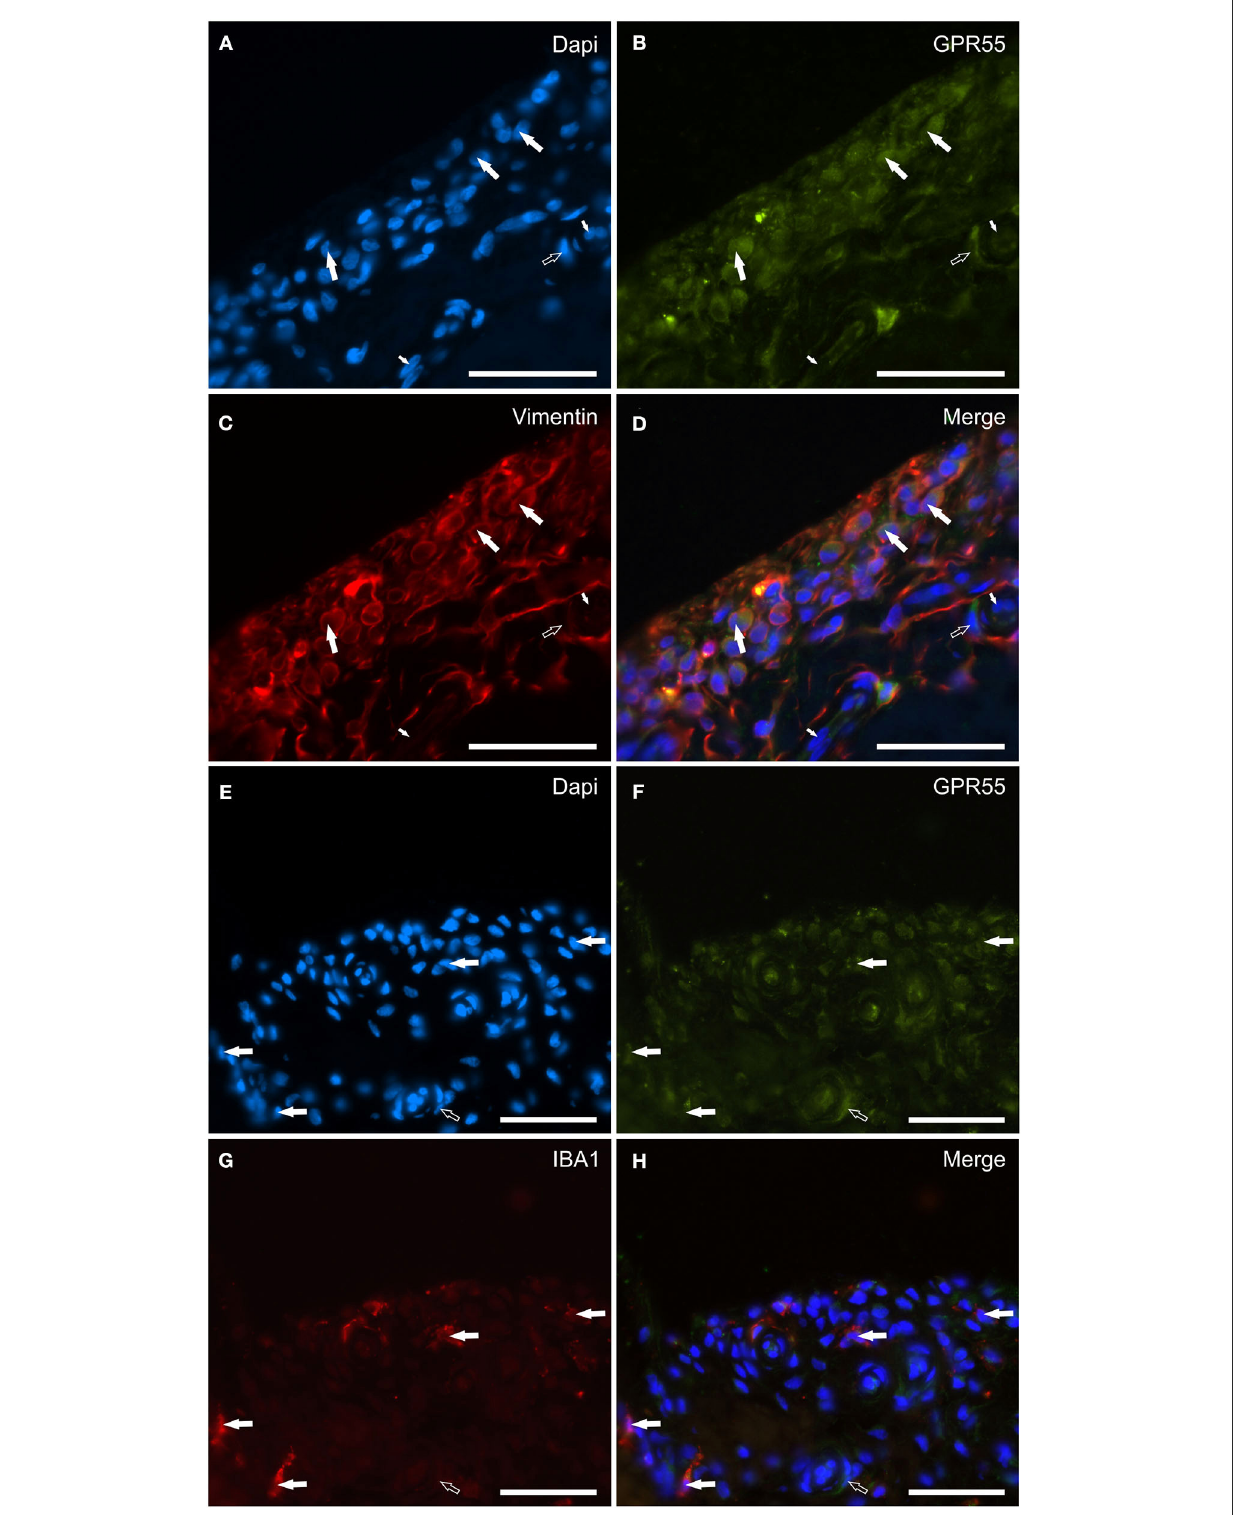
FIGURE7 Photomicrographs of the cryosections of the synovial membrane of a horse metacarpophalangeal joint showing G protein-related receptor 55 (GPR55) immunoreactivity in synoviocytes and vascular cells. (A–D) The white arrows indicate the DAPI (Blue) labeled nuclei (A) of elongated cells resembling fibroblast-like synoviocytes co-expressing moderate GPR55 (Green) (B) and bright vimentin (Red) (C) immunoreactivity. The small white arrows indicate the DAPI labeled nuclei of the endothelial cells of the subintima blood vessels showing moderate GPR55 immunoreactivity which was also expressed by the vascular smooth muscle cells (open arrow). (E–H) The white arrows indicate the DAPI (Blue) labeled nuclei of macrophage-like synoviocytes co-expressing faint-to-moderate GPR55 (Green) (F) and bright IBA1 (Red) immunoreactivity (G) . The open arrow indicates the nuclei of a vascular smooth muscle cell expressing moderate GPR55 immunoreactivity. (D, H) Merged images (orange). Scale bar = 50 µ